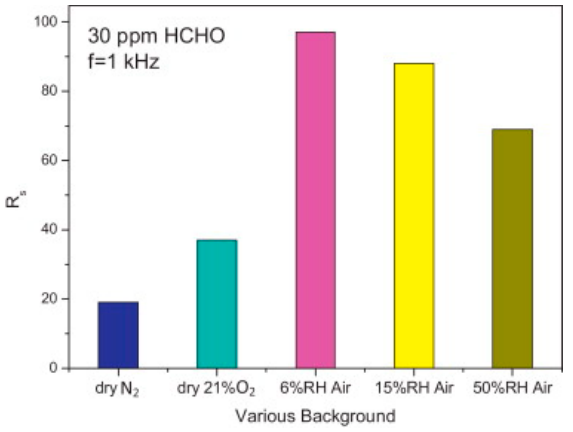
Figure 36. ( a ) SEM images of microporous TiO 2 and TEM images of ( b ) the larger particles and ( c ) the smaller aggregates shown in ( a ). Reproduced with permission from [65].